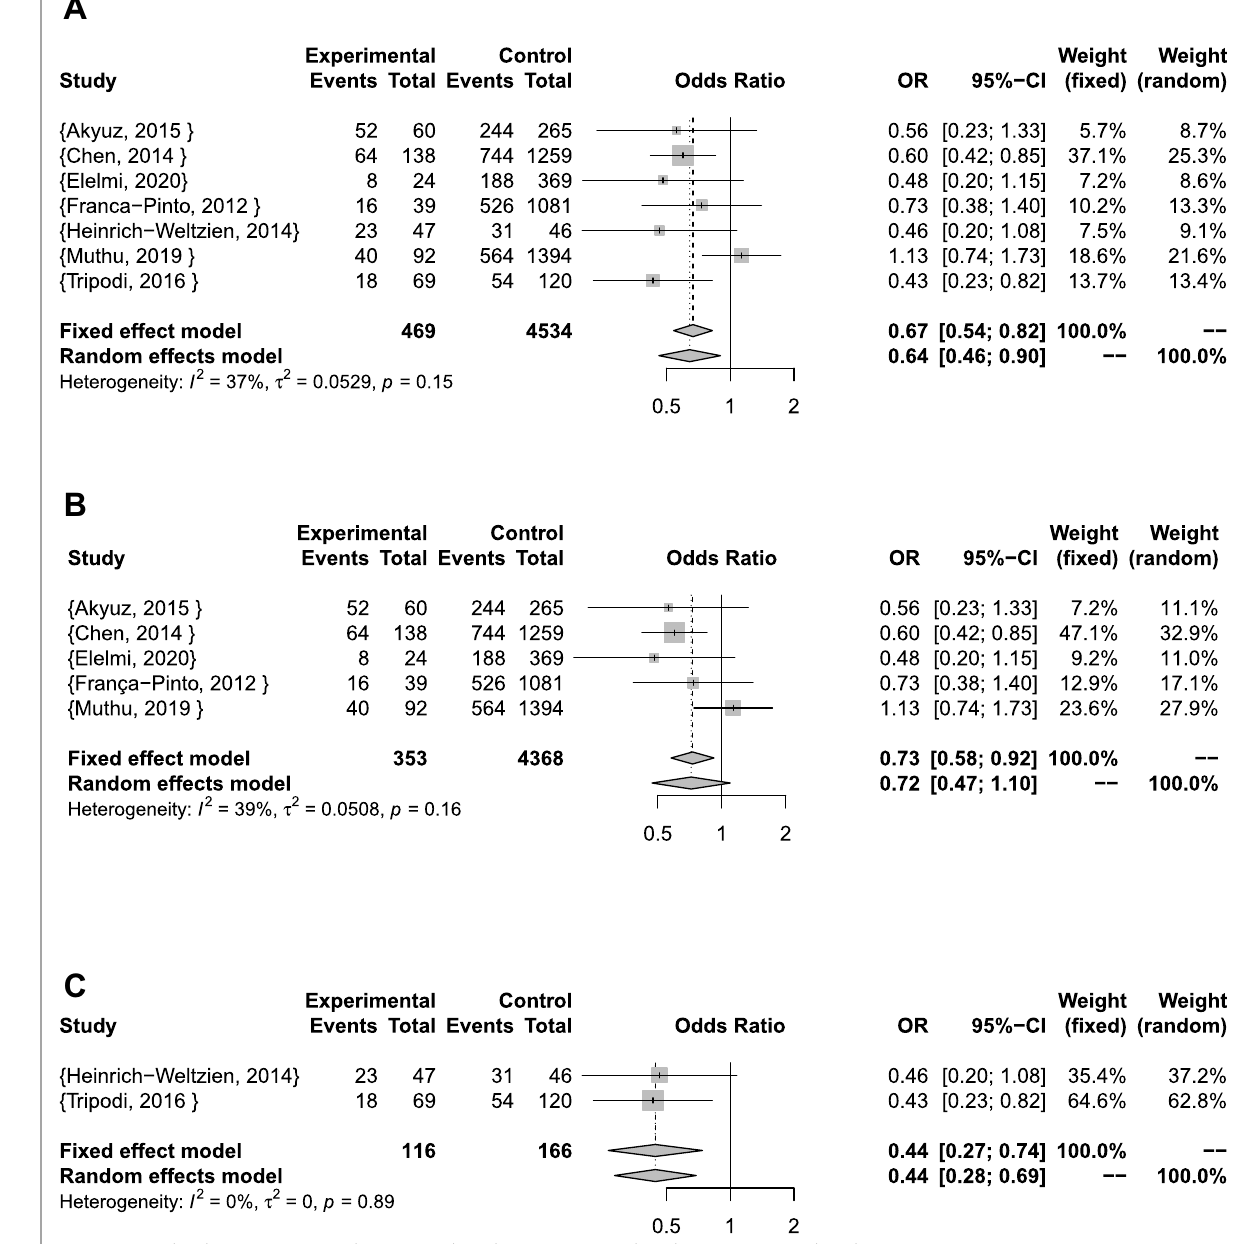
Fig. 2 Caries development meta-analyses A Combined B Cross-sectional studies C case-control